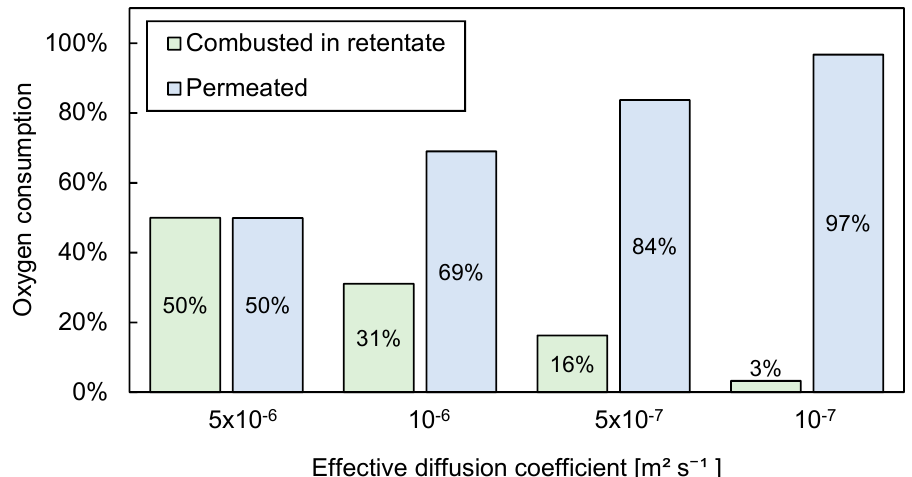
Figure 11. Sensitivity of effective diffusion coefficient using the distribution of oxygen consumption.